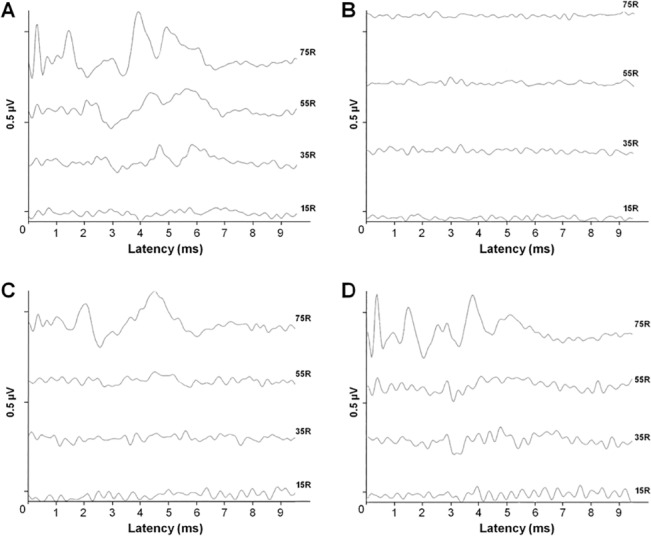
ABRs responses.Acoustic brainstem responses before, during and after hypoxia/ischemia exposure. A) Basaline. B) During HI event. C) 30 min. after HI event. D) 360 min. after HI event. We can observe four different traces associated to different intensities of ABR presentations showing that the responses disappear during exposure, partially recover after 30 minutes and completely recover after 360 minutes.